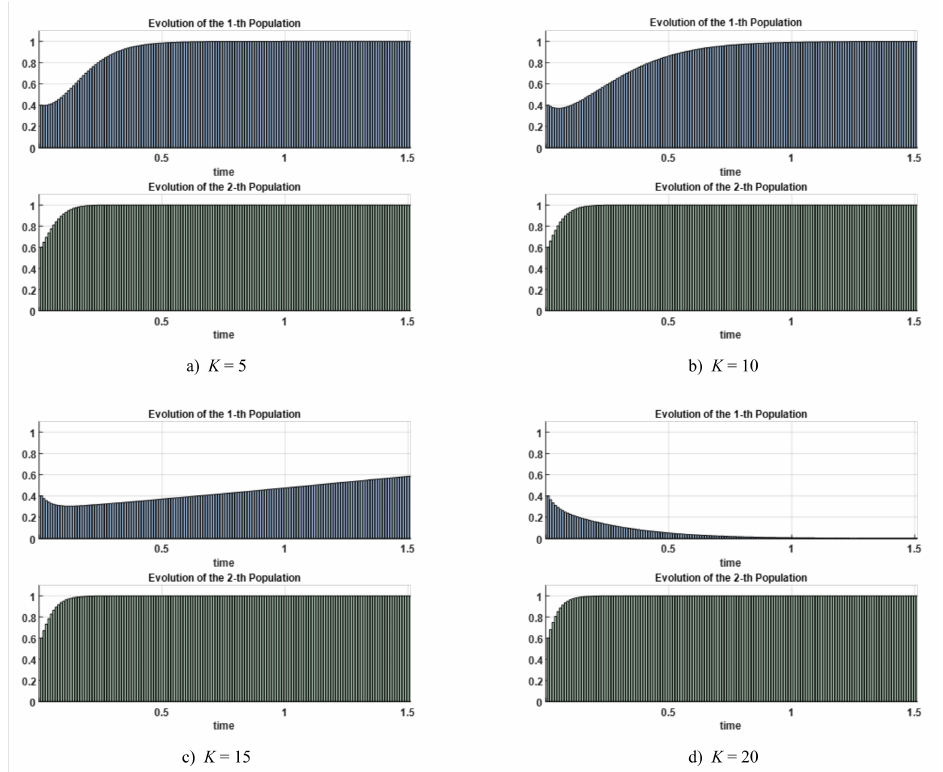
Figure 9. Influence of K change on system evolution (without government